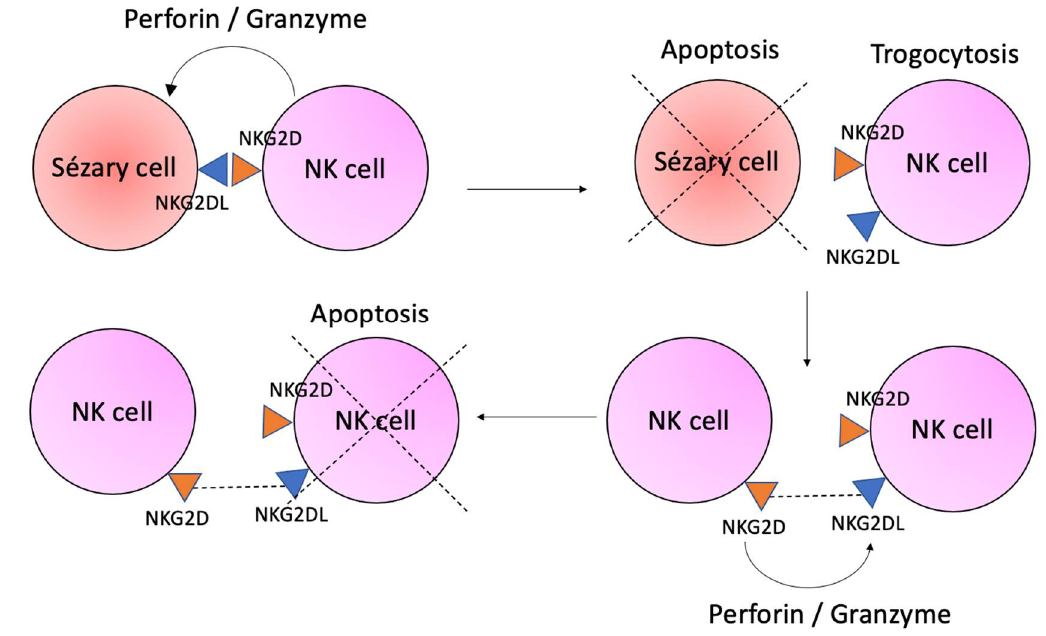
Figure 3. Trogocytosis process. The interaction of Sézary cells and NK cells by NKG2D/NKG2DL activates the degranulation of perforin and granzyme that kills malignant cells. The cell-to-cell contact allows the migration of NKG2DL from the Sézary cell to the NK cell in the trogocytosis process. The NK cell with NKG2DL is recognized by tumor-naïve NK cells that liberate perforin and granzyme, killing the NK cell.